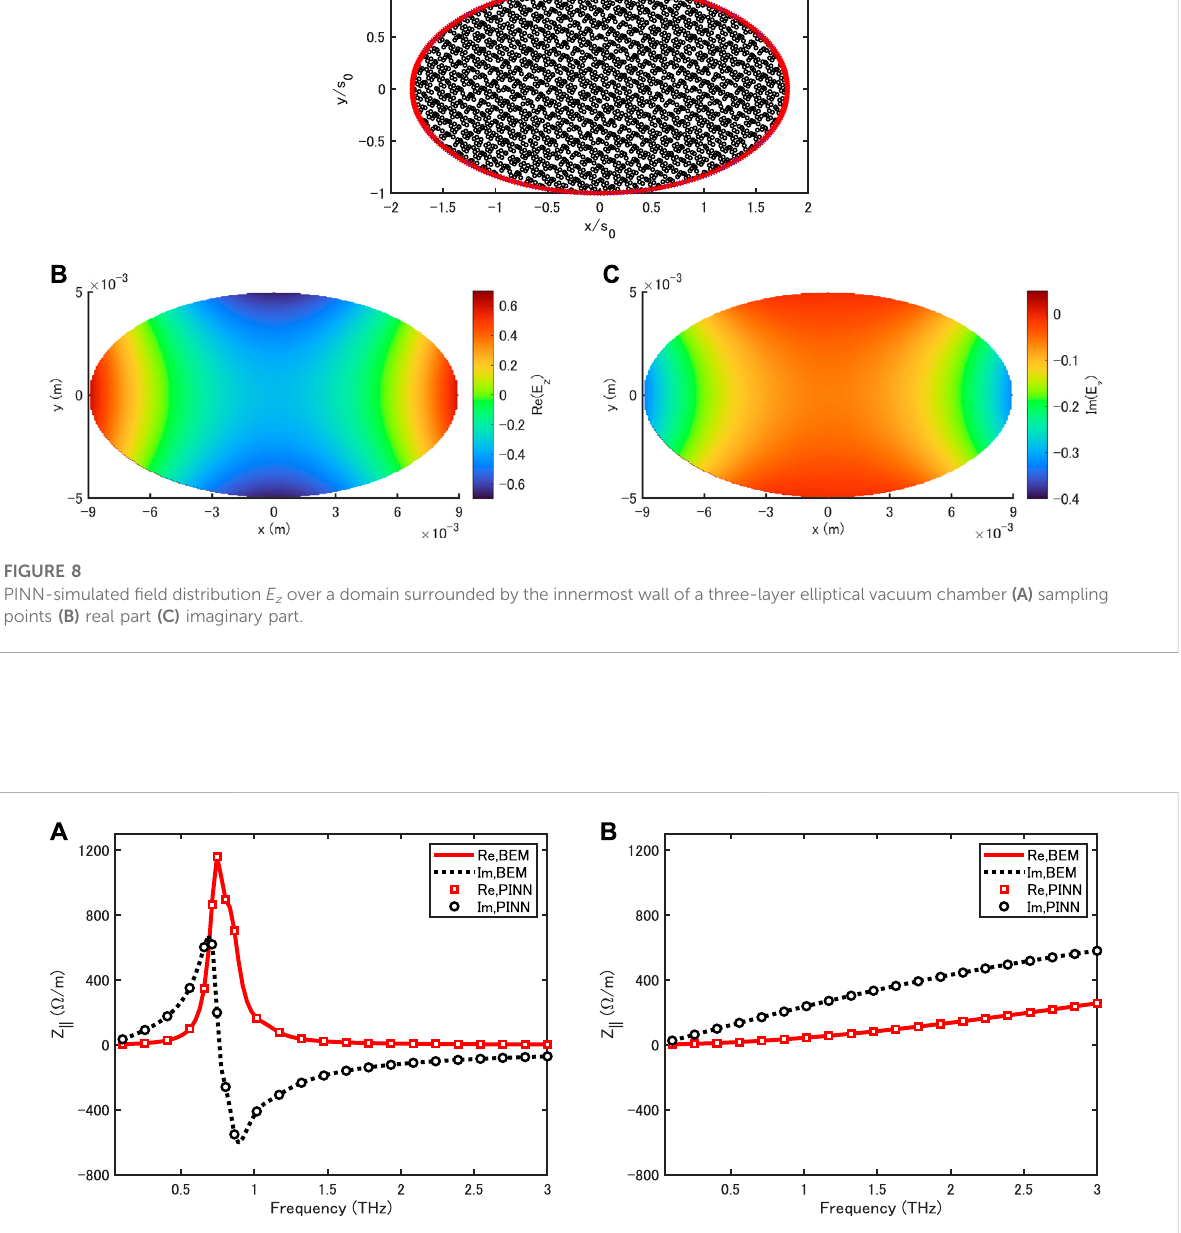
FIGURE 9 CouplingimpedanceofaroundGaussianbeamwith σ r =0.5 mmforanellipticalvacuumchamberwiththethree-layerstructureofcopper(Cu), stainless steel (SS), nonevaporable getter (NEG) (A) nonperturbative model (B) perturbative